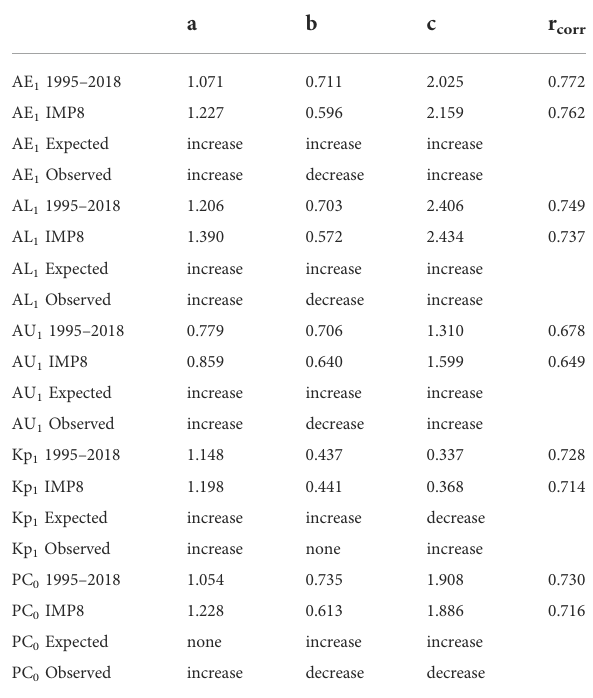
TABLE 2 For fi ve different geomagnetic indices the best- fi t exponents a, b, and c of the solar-wind driver D = v sw a B sw b sin c ( θ clock /2) are listed for the 1995 – 2018 OMNI2 solar-wind data and for the OMNI2 data that utilized measurements from IMP-8. The expected change in the a, b, and c exponents if there were a reduction of noise on sin( θ clock /2) and the observed change in the exponents a, b, and c (from Table 1) are listed.